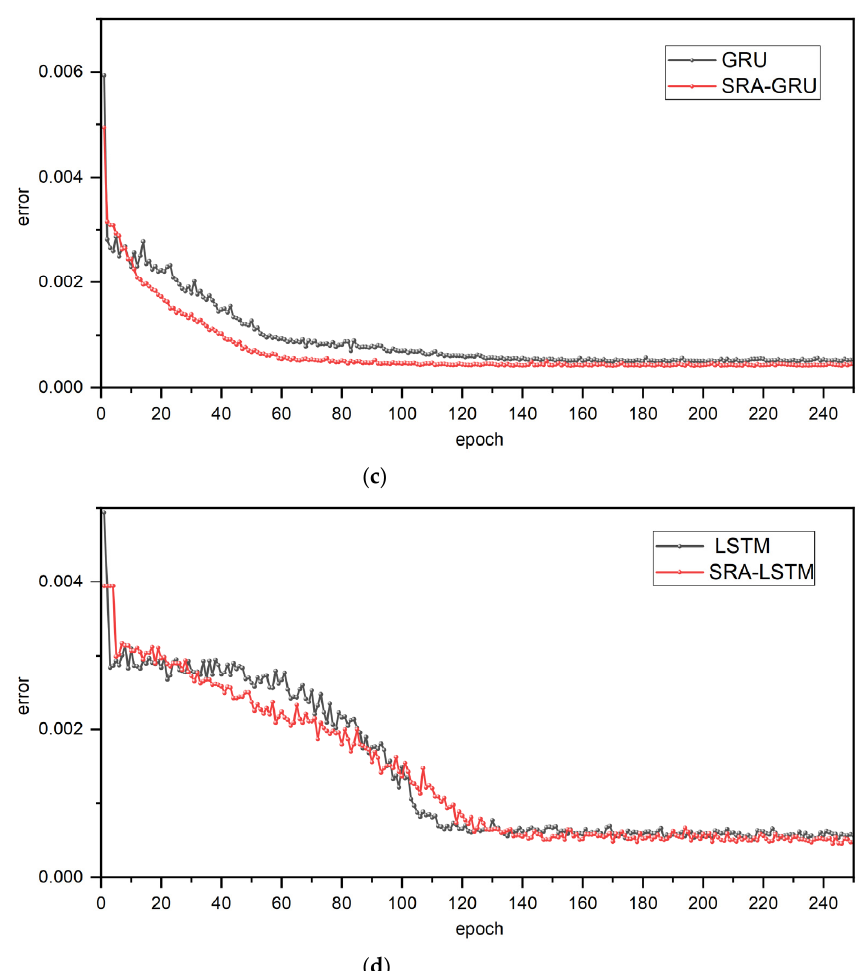
Figure 9. Loss value of comparative experiment based on the spatial-reduction attention. ( a ) SRA- BiGRU vs. BiGRU; ( b ) SRA-LSTM vs. BiLSTM; ( c ) SRA-GRU vs. GRU; ( d ) SRA-LSTM vs. LSTM.